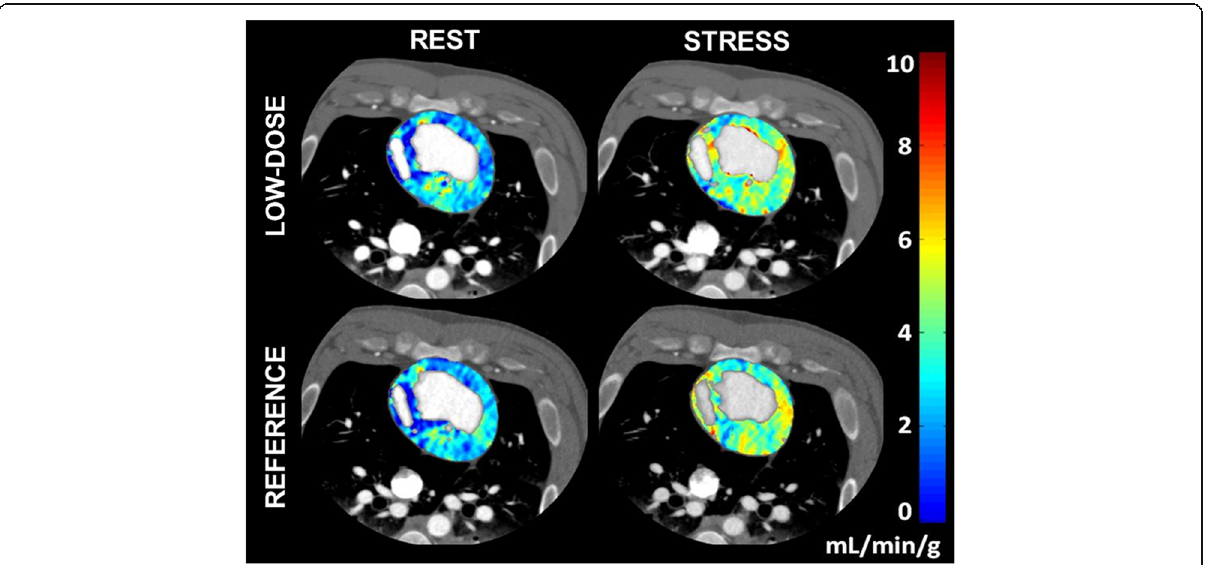
Fig. 6 Quantitative voxel-by-voxel first-pass analysis (FPA) perfusion maps. Low-dose rest (top left) and stress (top right) FPA perfusion maps are displayed as compared to reference standard retrospective rest (bottom left) and stress (bottom right) FPA perfusion maps. The color bar indicates myocardial perfusion in